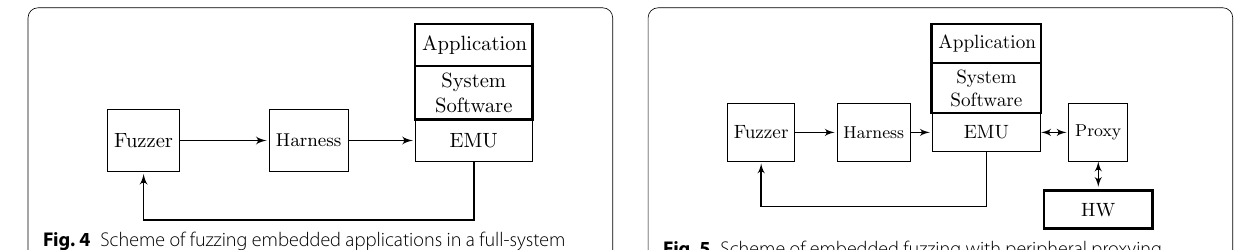
Fig. 5 Scheme of embedded fuzzing with peripheral